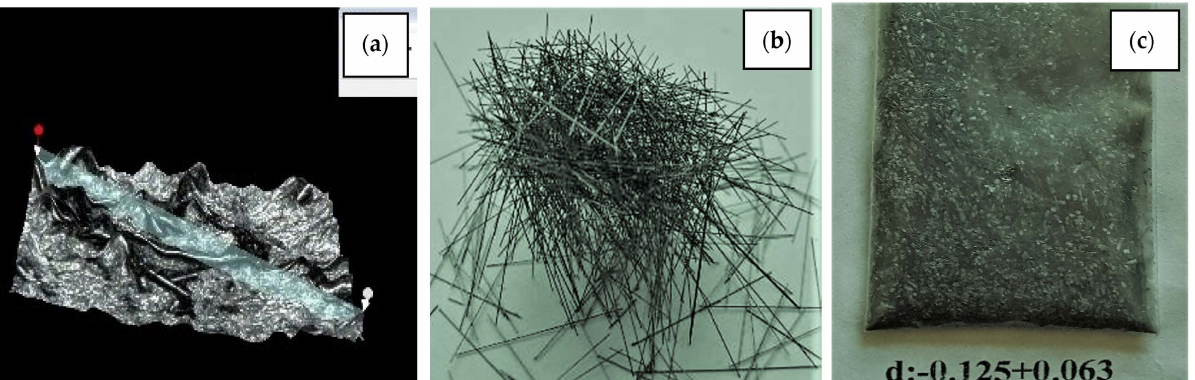
Figure 12. Boron-containing material: in an aluminium matrix ( a ); (W-B) fibres after chemical cleaning from aluminium matrix material: general view ( b ); W-B fibre powder ( c